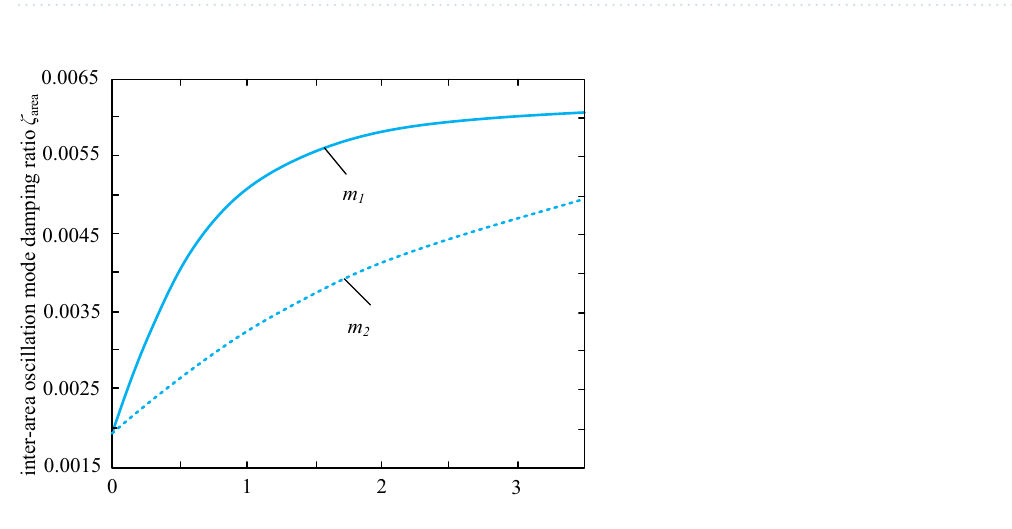
Figure 8. Comparison of sensitivity of oscillation mode damping ratio to damping coefficient.